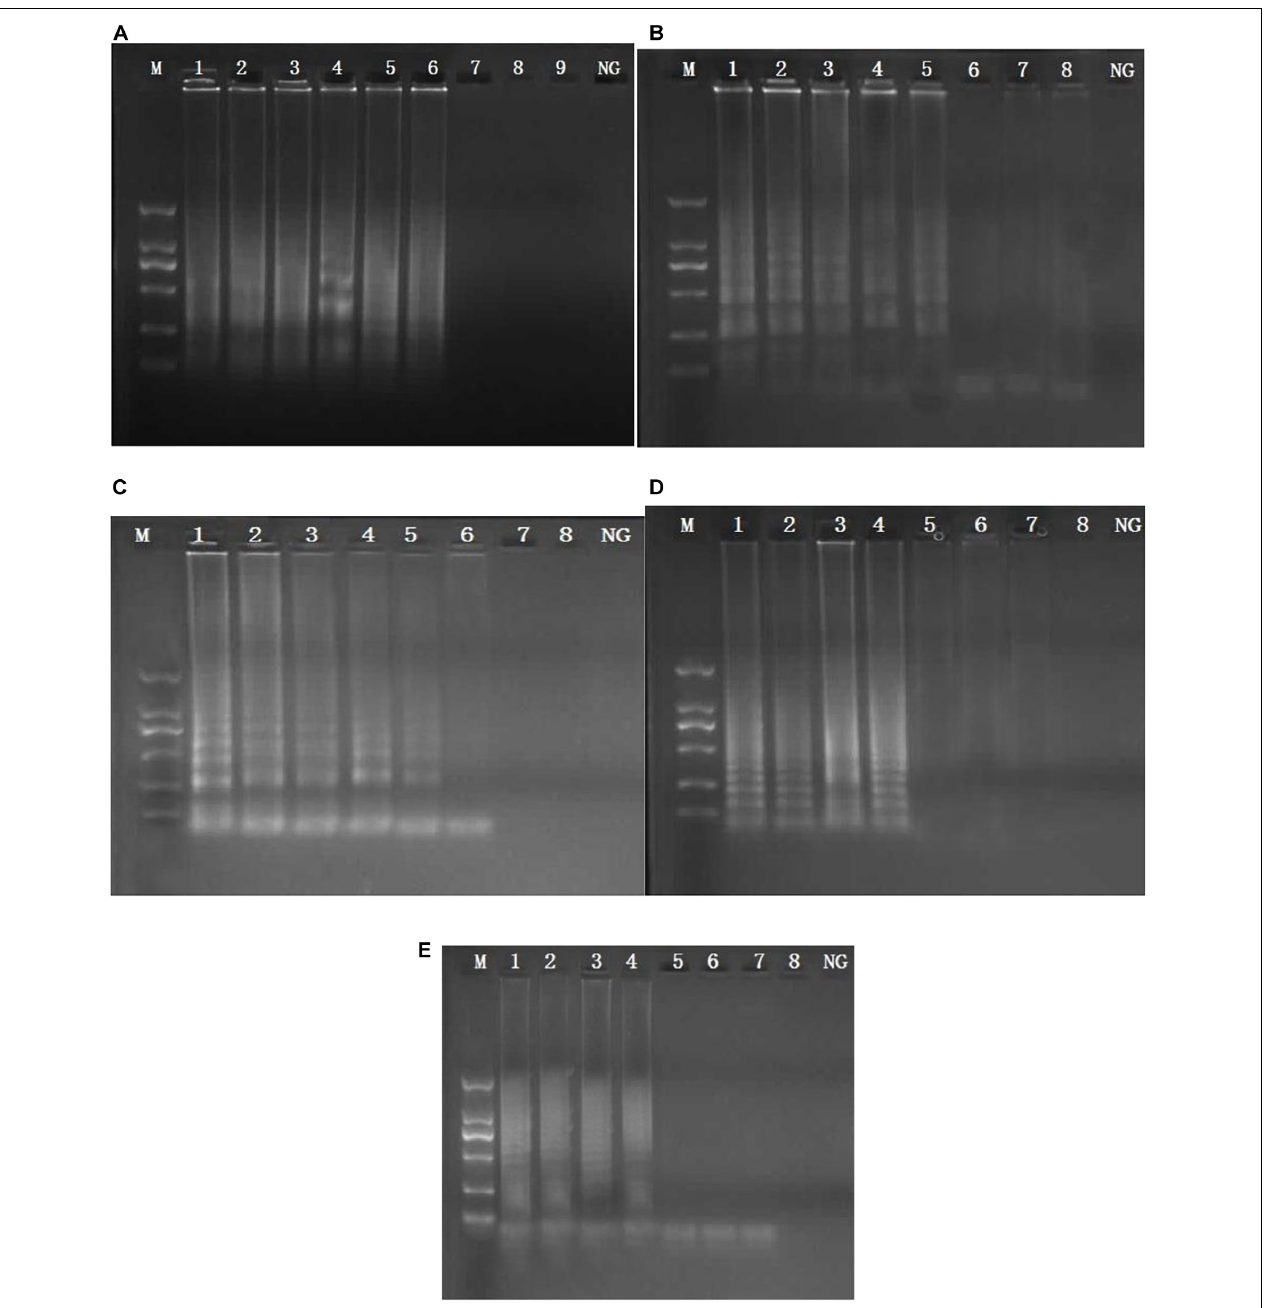
FIGURE 1 | Sensitivity of the CPA assay in genomic DNA by 1.5% agarose gel electrophoresis. Sensitivity from 10071 of femA (A) and mecA (B) genes. M, DNA marker; lanes 1–8, 3.0 ng/ µ l, 300 pg/ µ l, 30 pg/ µ l, 3 pg/ µ l, 300 fg/ µ l, 30 fg/ µ l, 3 fg/ µ l, 300 ag/ µ l NG—negative control. Sensitivity from 0214010085 of sea (C) : M, DNA marker; lanes 1–8, 3.0 ng/ µ l, 300 pg/ µ l, 30 pg/ µ l, 3 pg/ µ l, 300 fg/ µ l, 30 fg/ µ l, 3 fg/ µ l, 300 ag/ µ l NG—negative control. Sensitivity from 0315011480 of seb (D) : M, DNA marker; lanes 1–8, 4.3 ng/ µ l, 430 pg/ µ l, 43 pg/ µ l, 4.3 pg/ µ l, 430 fg/ µ l, 43 fg/ µ l, 4.3 fg/ µ l, 430 ag/ µ l NG—negative control. Sensitivity from 0214010085 of pvl (E) : M, DNA marker; lanes 1–8, 3.4 ng/ µ l, 340 pg/ µ l, 34 pg/ µ l, 3.4 pg/ µ l, 340 fg/ µ l, 34 fg/ µ l, 3.4 fg/ µ l, 340 ag/ µ l NG—negative